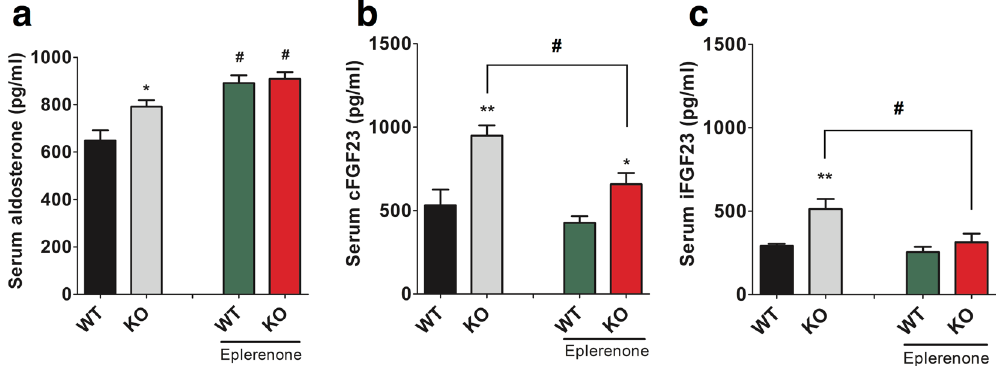
Figure 6. Effect of eplerenone on circulating aldosterone, cFGF23 and iFGF23 levels. ( a – c ) Arithmetic means ± SEM (n = 6–7) of serum aldosterone ( a ), serum cFGF23 ( b ), and serum iFGF23 ( c ) in NCC WT mice NCC KO under baseline and following oral eplerenone treatment for 7 days (right bars). * (p < 0.05) indicates significant difference from NCC WT mice, # (p < 0.05) indicates significant difference from eplerenone